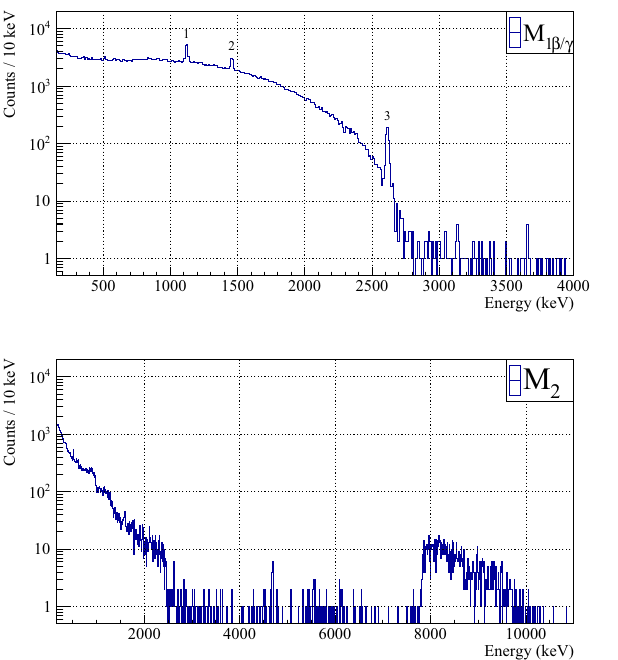
Fig. 2 Top left: CUPID-0 M 1 β/γ spectrum with the following peak labeling: (1) 65 Zn, (2) 40 K, (3) 208 Tl. Top right: M 1 α spectrum with the following peak labeling: (1) 232 Th, (2) 228 Th, (3) 224 Ra, (4) 212 Bi,